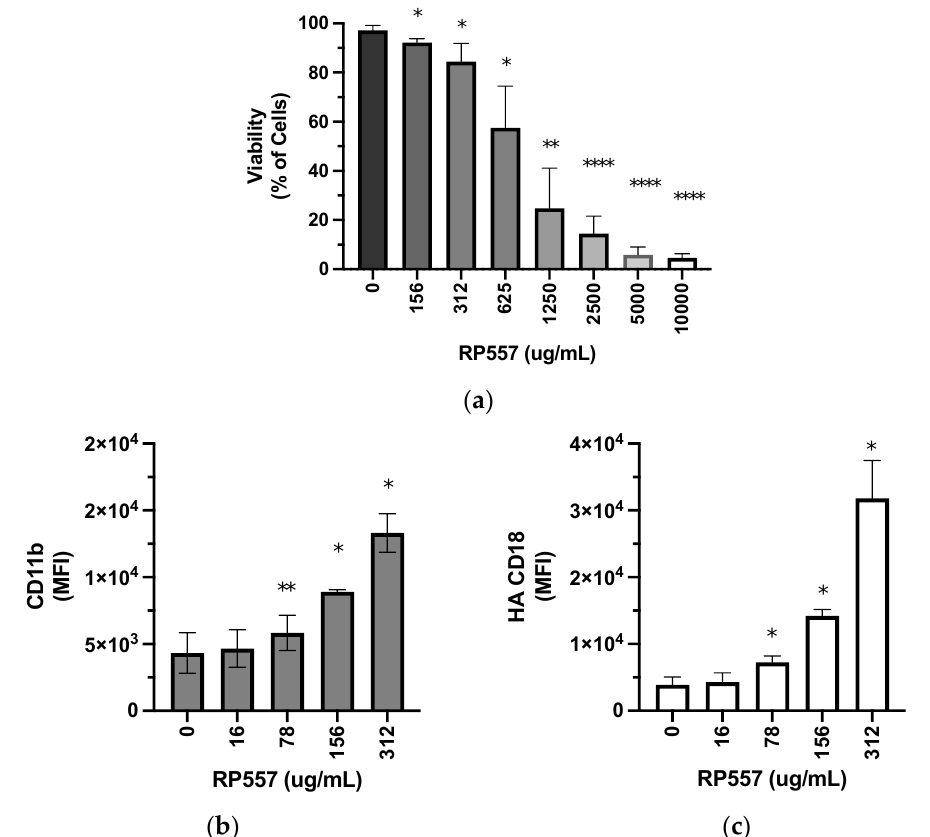
Figure 1. Neutrophil viability and integrin expression in response to incubation with RP557. ( a ) Viability of isolated human neutrophils incubated for 30 min with varying concentrations of RP557 solution as determined using propidium iodine fluorescence staining and flow cytometry. Paired ratio t -test was performed comparing the average value for an experimental condition to the untreated condition of the same donor ( n = 4 per group). Isolated human neutrophils were incubated with varying concentrations of RP557 for 20 min at 37 °C, washed, and stained with antibodies for 15 min at 37 °C, followed by fixation and quantification by flow cytometry of ( b ) CD11b and ( c ) high affinity CD18. The data are presented as the mean fluorescence intensity ± SEM ( n = 3 donors) with experimental replicates averaged for each donor. Paired t -tests were performed comparing the average value of the experimental condition to the 0 µ g/mL control condition of the same donor. MFI: mean fluorescence intensity. *, **, and **** denote p -values of ≤ 0.05, ≤ 0.01, and ≤ 0.0001, respectively.